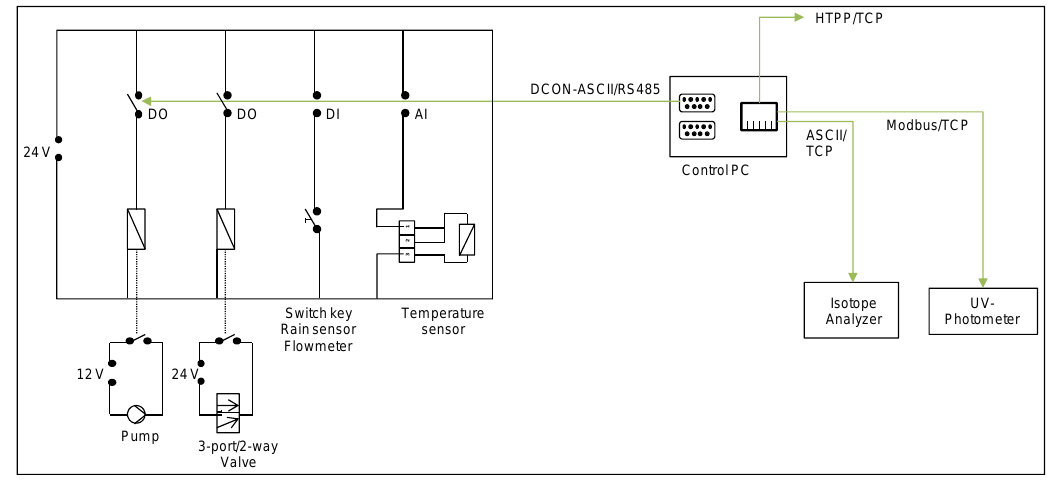
Figure 5. Schematic circuit diagram of the switch cabinet including analogue input, digital in- and output cards with connections to pumps, valves, push button, rain sensor, flowmeter and temperature sensors as well as a connection to the control PC and connections from the control PC to the analytical equipment and the